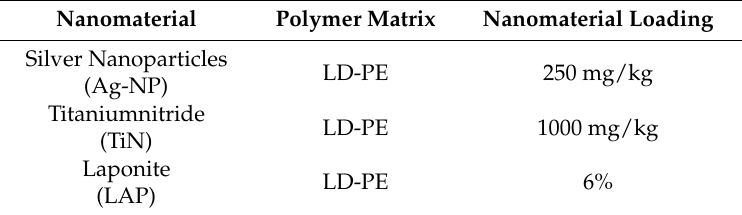
Table 1. LDPE-based nanocomposites used as test